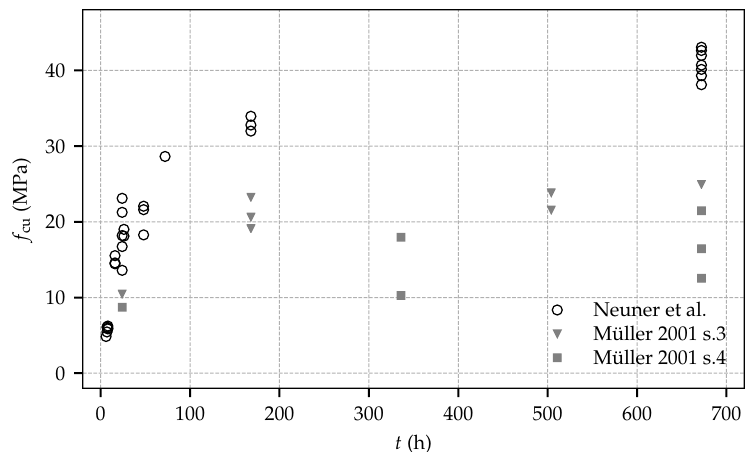
Figure 4. Evolution of the uniaxial compressive strength: experimental results from the present experimental program and test data by Müller.